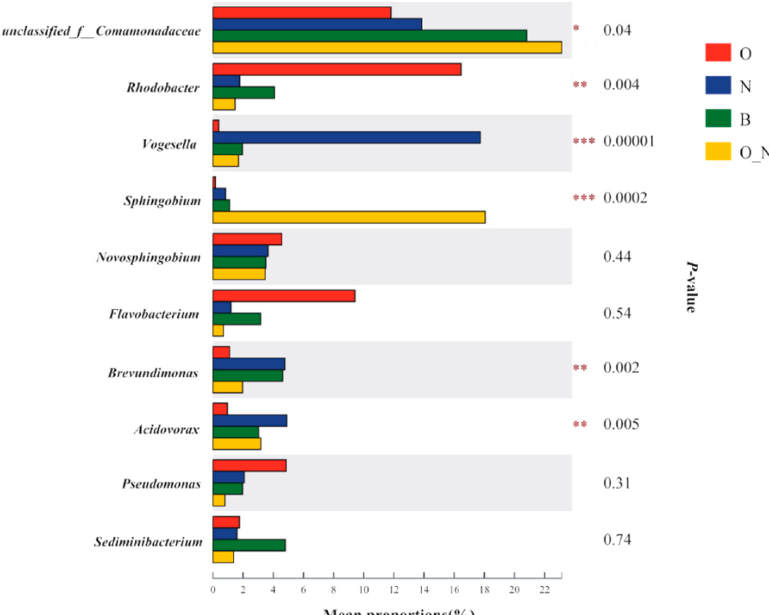
Figure 8. The tests of statistically significant differences between groups. The ten most abundant genera are shown. The length of corresponding columns denotes the mean relative abundance of a genus in different groups; the p -value of significance is shown on the right side, *, 0.01 < p < 0.05; **, 0.001 < p < 0.01; ***, p <